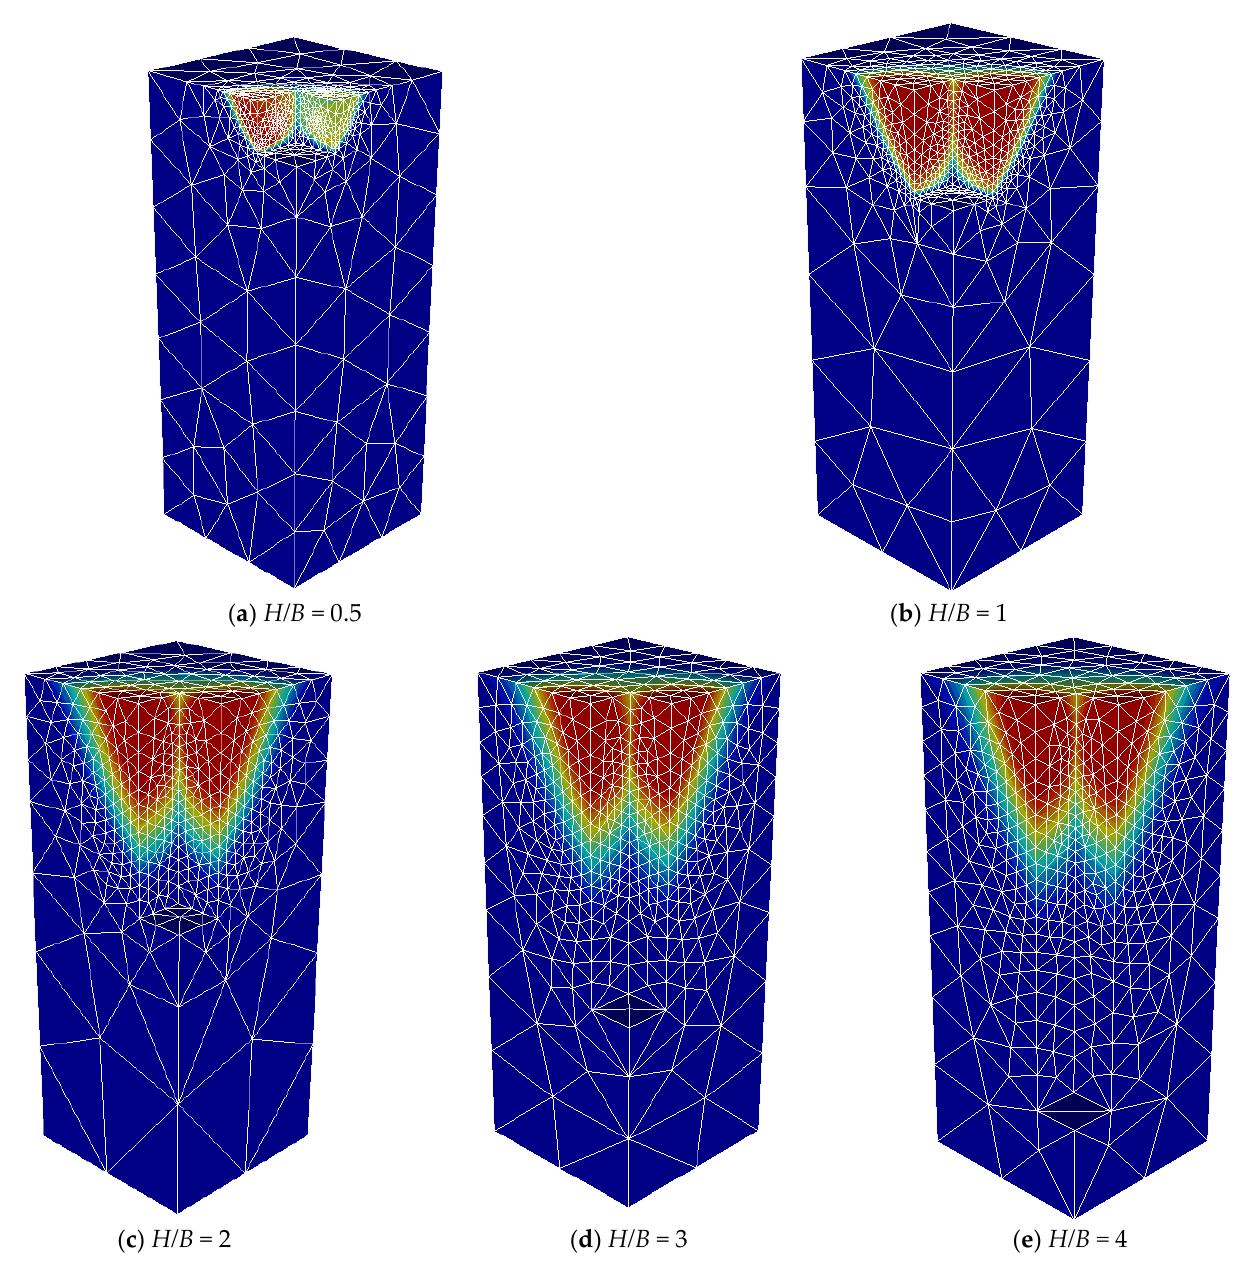
Figure 5. N vs. H/B for the various r e ( B/L = 0.25, 1.0 and m = 0, 12, 100).